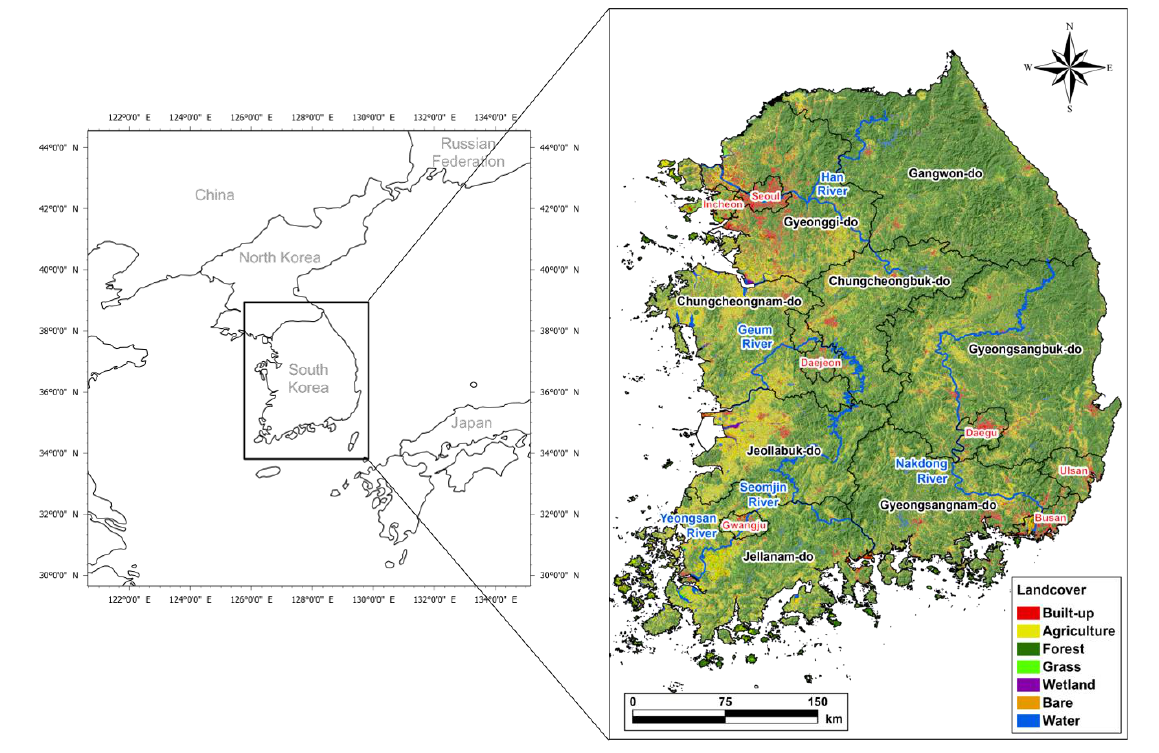
Figure 1. Location and land cover of the study area based on Ministry of Environment, South Korea, 2019.